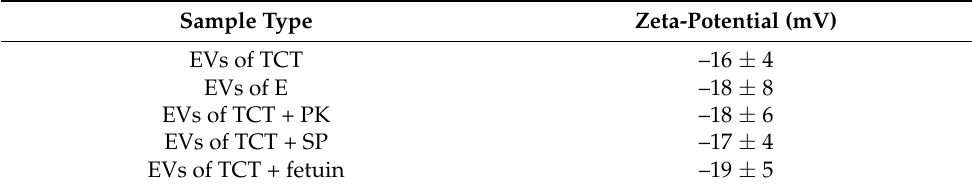
Table 2. Zeta-potential of EVs of TCT, EVs of E and EVs of TCT after the treatment/incubation with different reagents/proteins